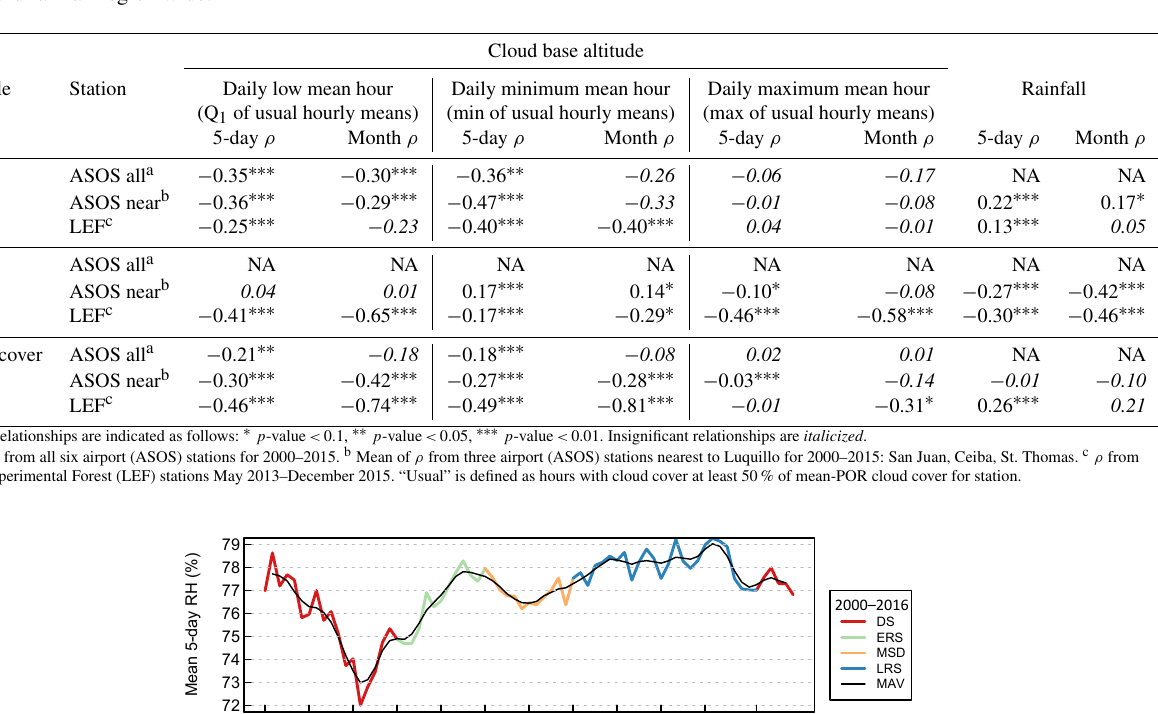
Table 3. Correlation coefficients ρ of relative humidity (RH), mean sea level pressure (MSLP), and cloud cover with cloud base altitude metrics and rainfall region wide.